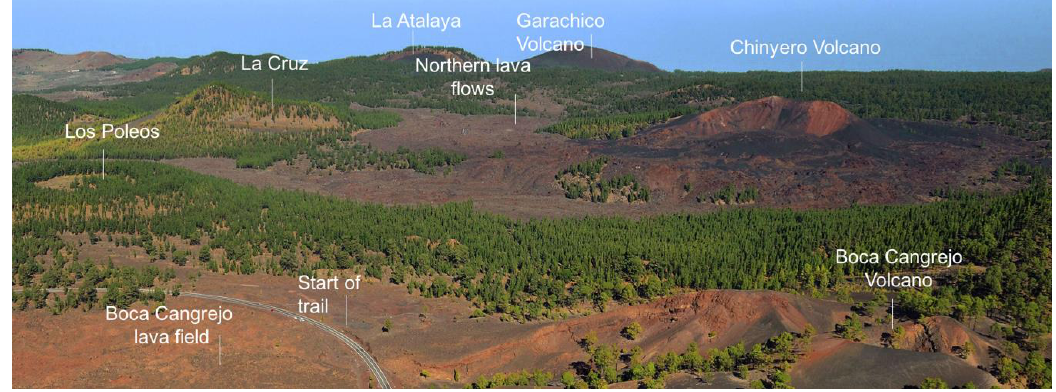
Figure 7. View of the Chinyero highlands. Source: http: // www.fotosaereasdecanarias.com, self-elaboration. 5.1. Stop 1: Start of Trail. 28 ◦ 17’4.87” N 16 ◦ 45’42.14”